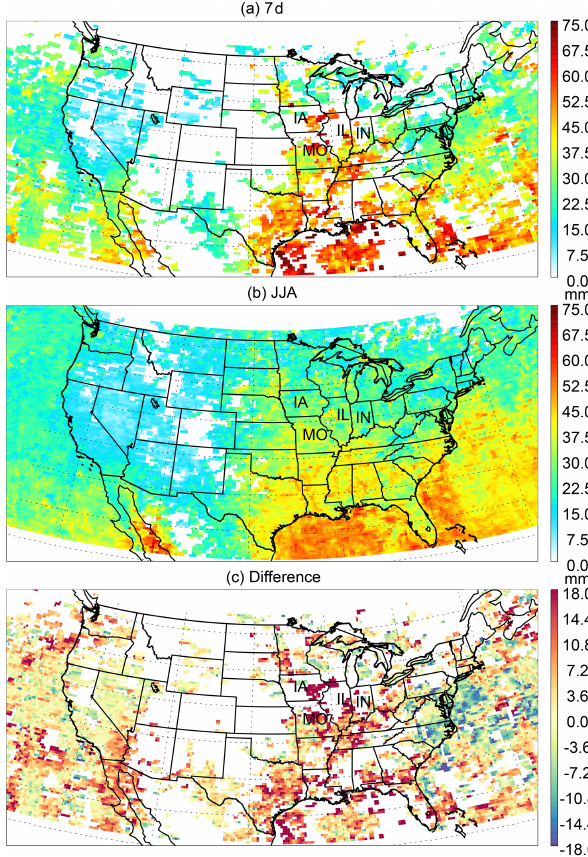
Figure 8. Level 3 (0 . 25 ◦ × 0 . 25 ◦ ) OMI TCWV (mm) generated us- ing the Level 2 data during (a) 18–24 July 2016 and (b) 1 June– 31 August 2016. (c) The difference of (a) – (b) in millimeters. The abbreviations for the states most affected by the event are indicated in the map.